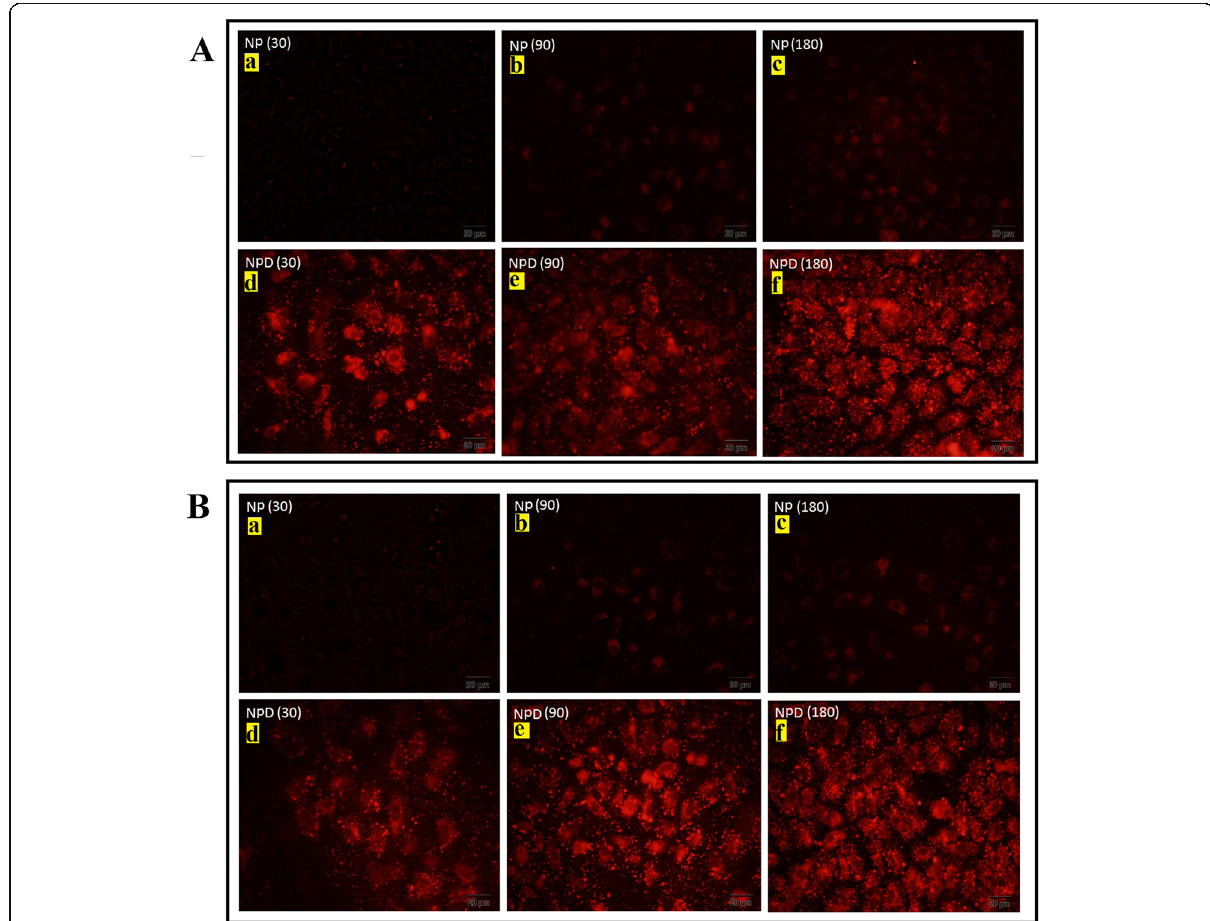
Fig. 5 A Qualitative cell uptake assay using Rhodamine B-labelled Au@SiO 2 nanoparticles (NP) in MCF7 with exposure durations of 30 ( a ), 90 ( b ) and 180 ( c ) min or rhodamine B-labelled MTX-FA loaded Au@SiO 2 nanoparticles (NPD) with exposure durations of 30 ( d ), 90 ( e ) and 180 ( f ) min and ( B ) Qualitative cell uptake assay using Rhodamine B-labelled Au@SiO 2 nanoparticles (NP) in MDA-MB-231 with exposure durations of 30 ( a ), 90 ( b ) and 180 ( c ) min or rhodamine B-labelled MTX-FA loaded Au@SiO 2 nanoparticles (NPD) with exposure durations of 30 ( d ), 90 ( e ) and 180 ( f ) min captured by florescent